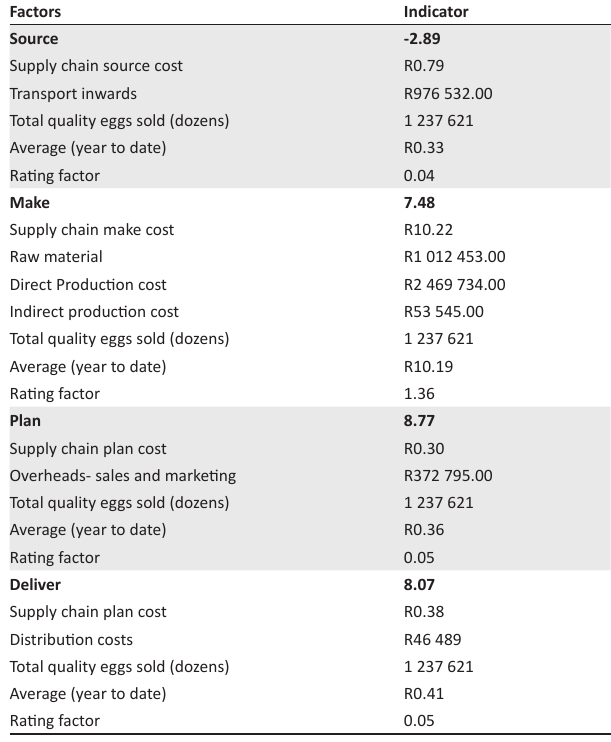
TABLE 25: Final representation of the cost leg of the developed model.